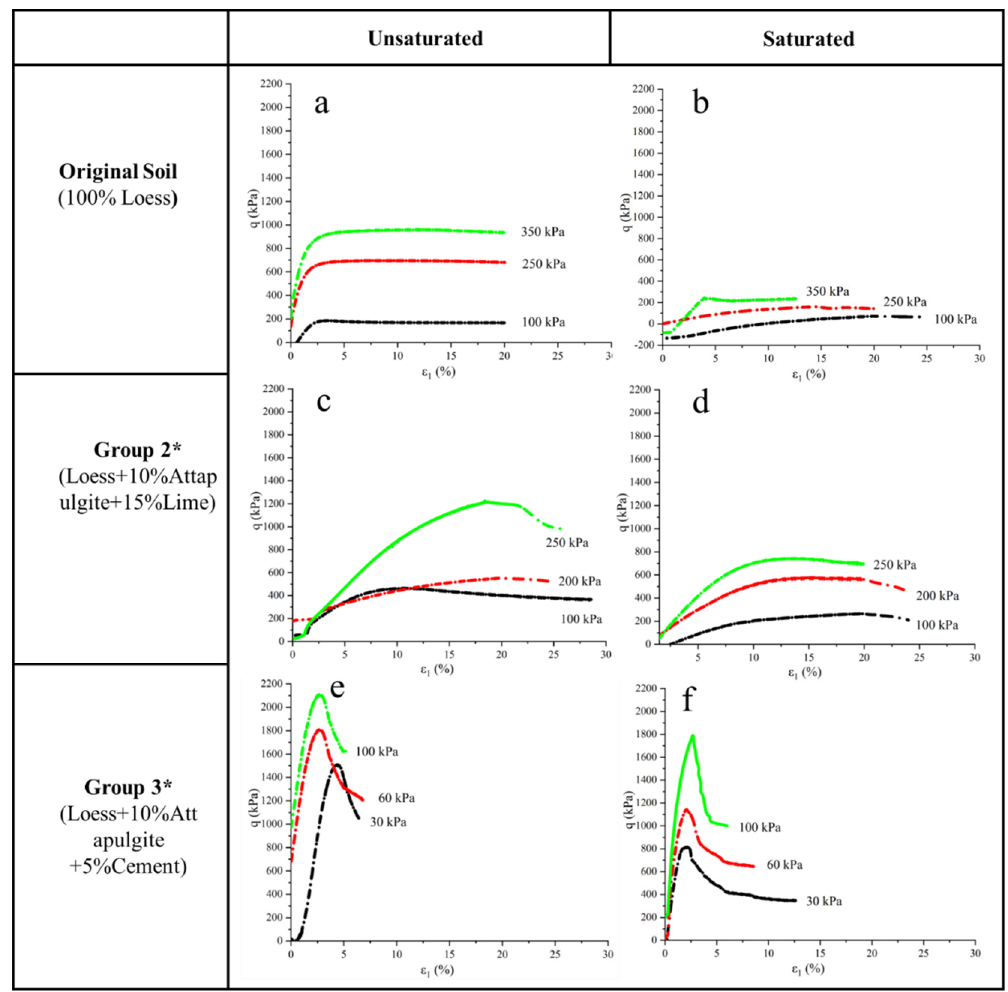
Figure 10. Stress–strain curve: ( a ) unsaturated loess; ( b ) saturated loess; ( c ) unsaturated attapulgite- lime-modified loess; ( d ) saturated attapulgite-lime-modified loess; ( e ) unsaturated attapulgite-cement-modified loess; ( f ) saturated attapulgite-cement-modified loess. * Optimum permeability co- efficient.